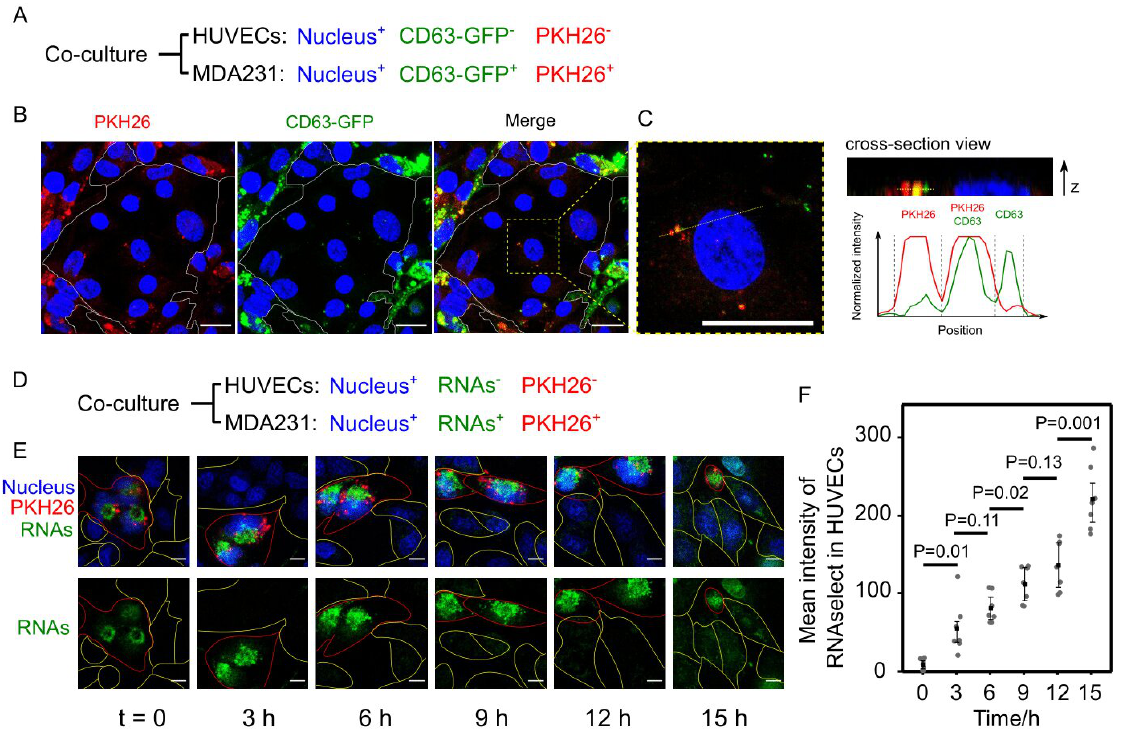
Figure 3. Fluorescent trafficking of the transfer of EVs and RNAs from MDA231 to HUVECs. ( A ) HUVECs and MDA231 were differentially stained and co-cultured. CD63-GFP and PKH26 were used to double label the MDA231-derived EVs. ( B ) After 24-h co-culture, EVs labeled by CD63-GFP or PKH26 were internalized by HUVECs. Scale bars = 20 µ m. ( C ) Enlarged view of internalized EVs in HUVECs. The z-position of the EVs did not exceed the height of nucleus, indicating that the EVs were inside the cell rather than on the cell surface. The EVs were either PKH26+ or CD63+. Scale bars = 20 µ m. ( D ) SYTO RNASelect was used to stain RNAs in MDA231. ( E ) The fluorescent RNAs from MDA231 gradually accumulated in HUVECs in 15-h live cell imaging. MDA231 and HUVECs are marked by lines in red and yellow, respectively. Scale bars = 10 µ m. ( F ) Significant elevations of fluorescent RNAs in HUVECs were observed after 3 h ( N = 7). The average intensity of RNAs in HUVECs was measured by ImageJ and the P value was calculated based on Student’s t